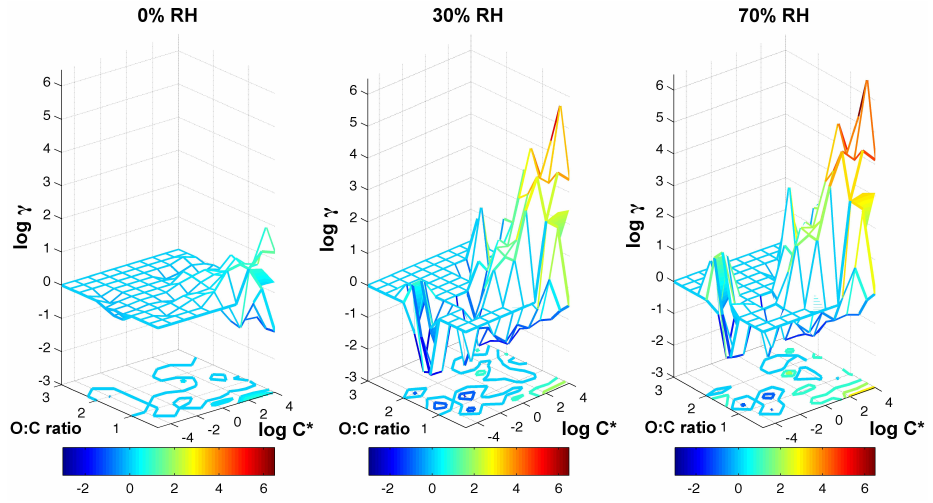
Fig. 9. Surface plots of log 10 (γ i ) for the non-ideal calculation (2742 compounds, p 0 by N-N/VP, γ i by UNIFAC) using the standard scenario (1.0/1.0/1.0 NO x -SF/AVOC-SF/BVOC-SF) under conditions T = 293 . 15K; %RH = 0, 30 or 70; and 0.5µgm − 3 involatile core. The two meshes show the minimum and maximum activity coefficients as a function of O:C ratio and log 10 (C ∗ ) . The contour plot on the base of the figure shows the median value for each